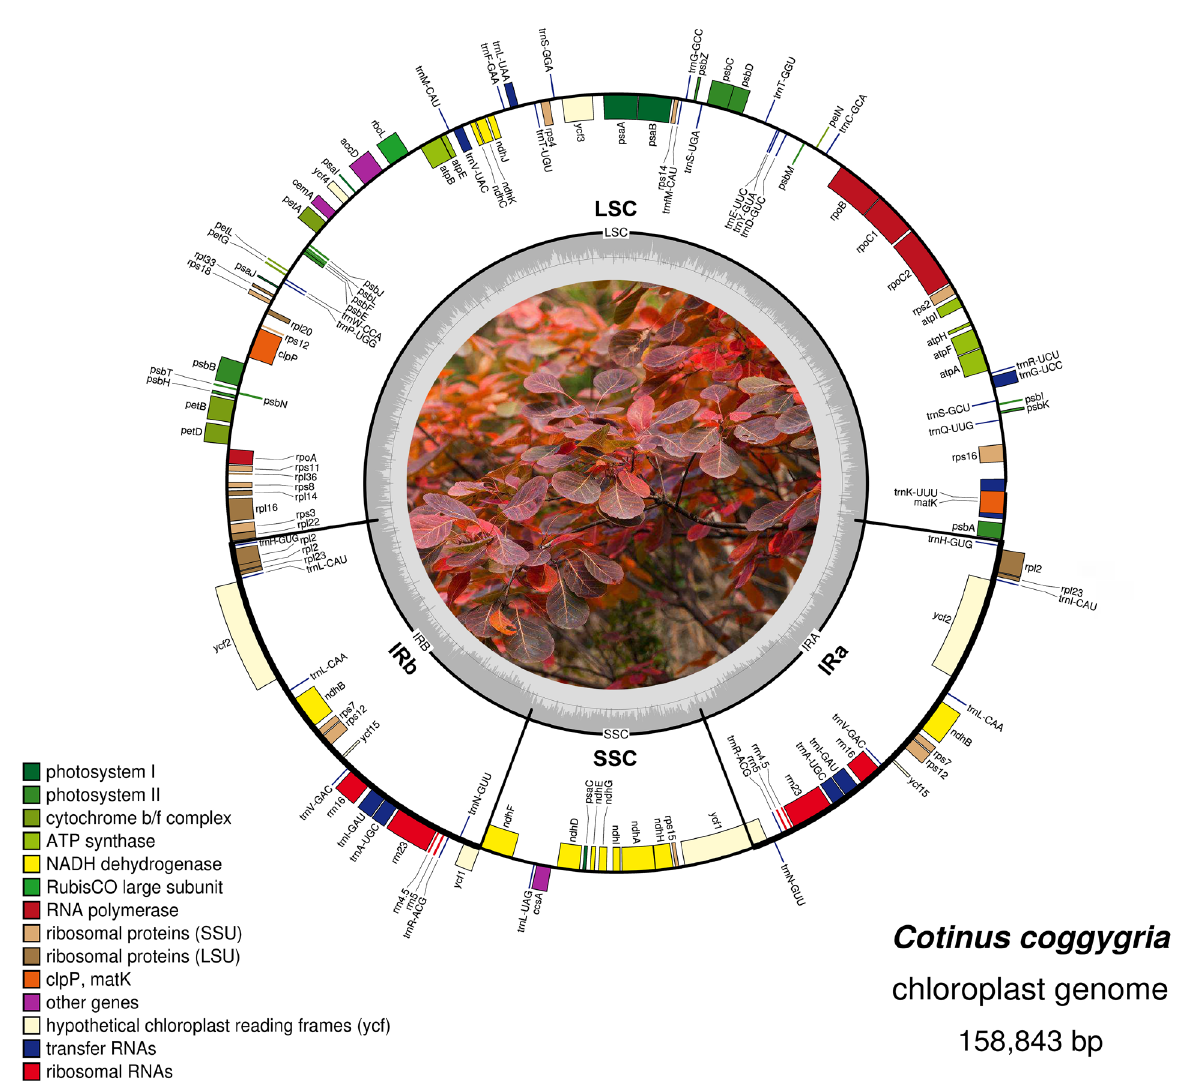
Figure 1 – Graphic representation of features identified in the cp genomes of C. coggygria by using OGDRAW. The plastome has a conservative quartile structure composed of a LSC region, a SSC region and a pair of IR regions. The genes outside the circle are transcribed in counter clockwise direction, and the genes inside the circle are transcribed in clockwise direction. Different colors in genes represent different functions. The dark gray and light gray areas of the inner circle represent the GC content to AT content of the genome,